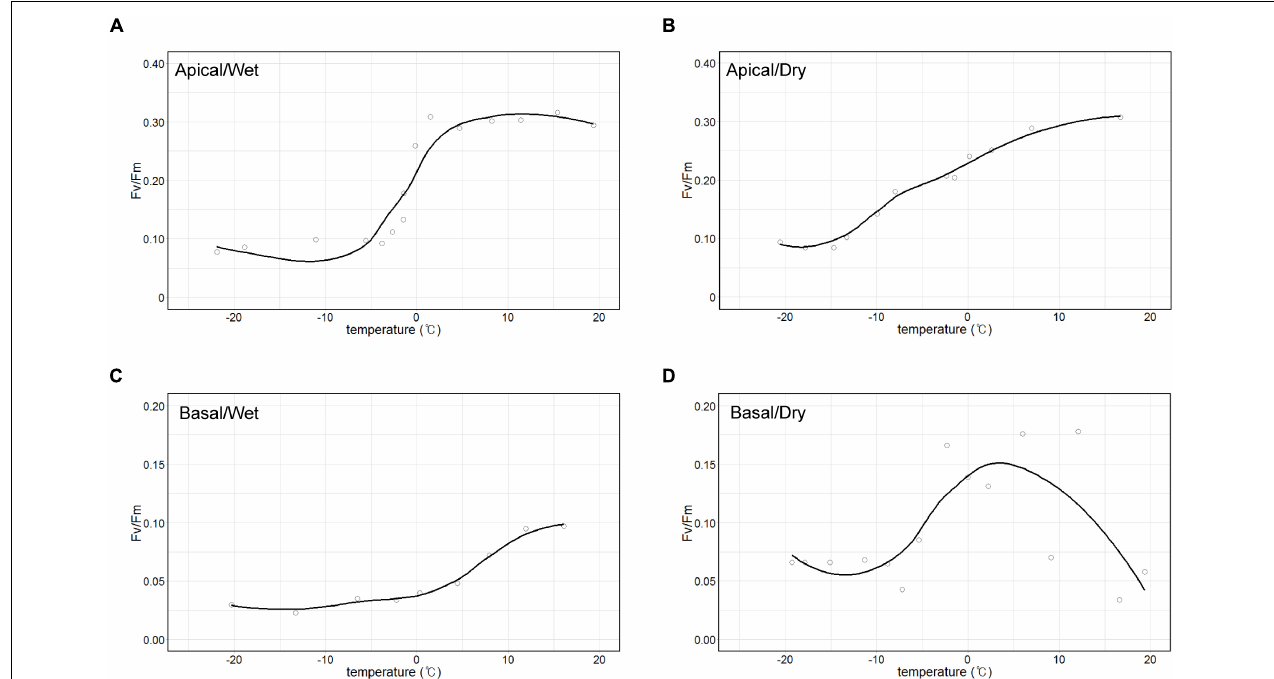
FIGURE 7 | Temperature-response curves of maximum photochemical quantum yield of PS II ( Fv/Fm ). Apical parts in wet (A) and dry (B) air conditions and basal parts in wet (C) and dry (D) air conditions.